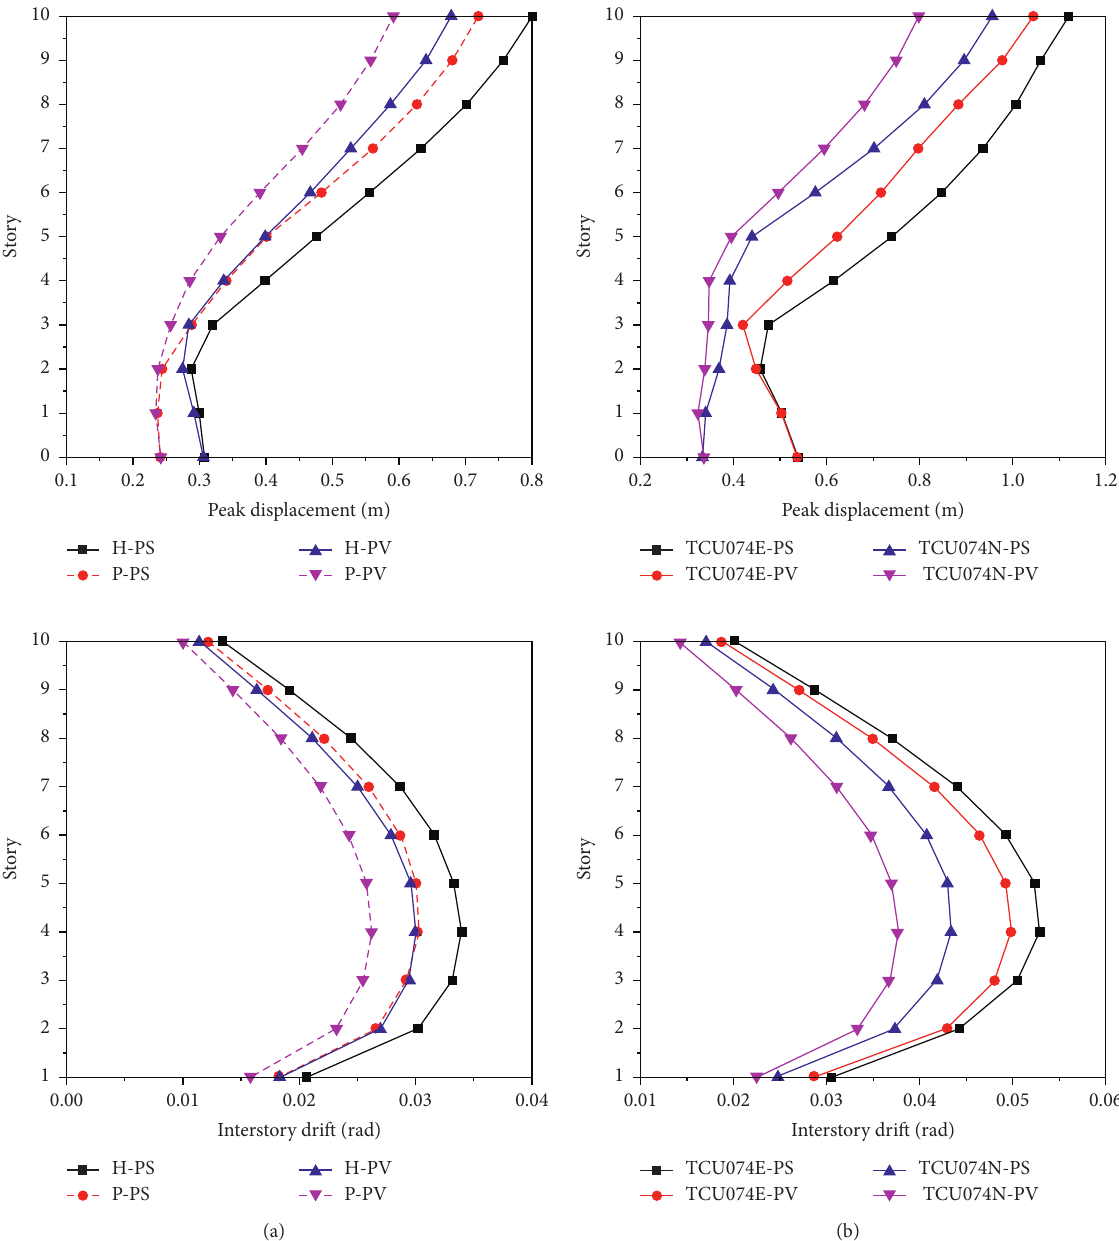
Figure 19: (a) The average peak displacement of the structure under the horizontal component and parallel component of near-fault ground motion; (b) the peak displacement of the structure under the ground motion of